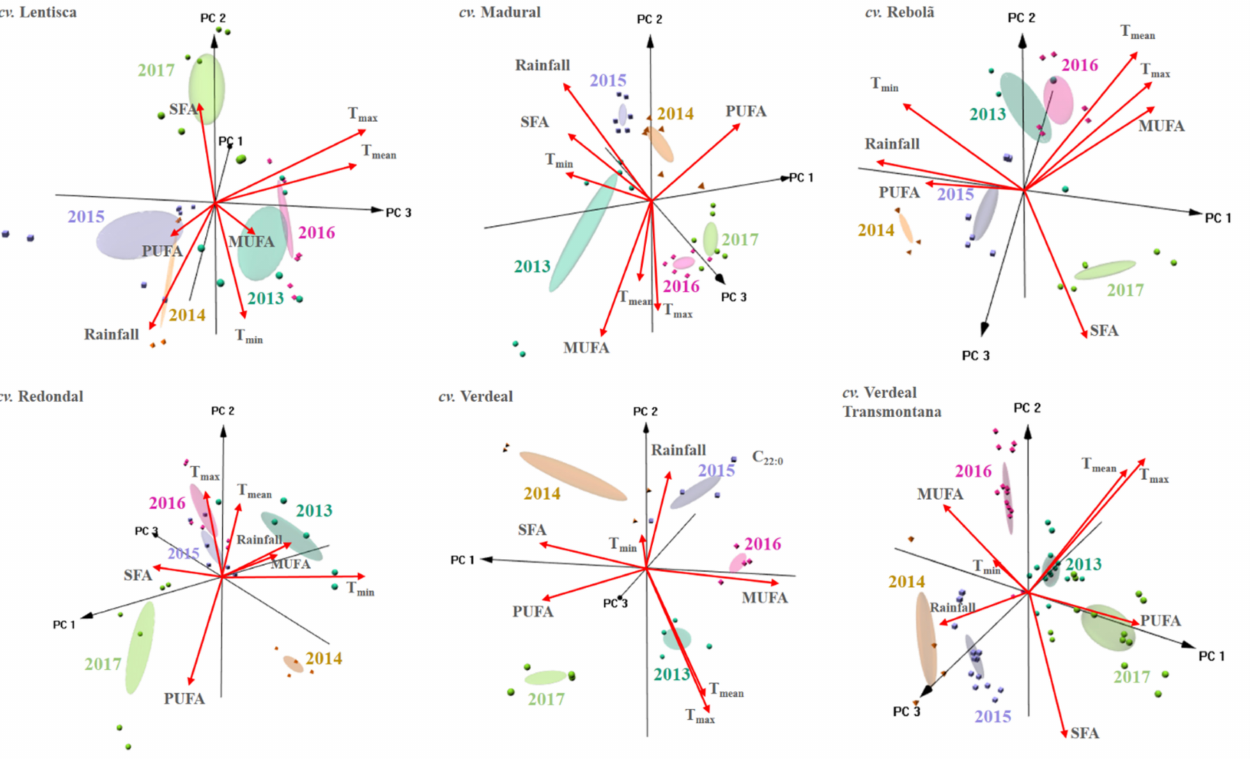
Figure 3. Principal component analysis for olive oils from each individual olive cultivar: 3D biplot showing the unsupervised pattern recognition according to crop year (2013 to 2017) on the basis of climatic data (minimum, mean, and maximum average temperatures (T min , T mean , and T max , respectively, in ◦ C) and total rainfall (mm) recorded in the months of August, September, and October in Mirandela region, northern Portugal) and fatty acid profile (%) (C 14:0 , C 16:0 , C 16:1 , C 17:0 , C 17:1 , C 18:0 , C 18:1 , C 18:2 , C 18:3 , C 20:0 , C 20:1 , C 22:0 , C 22:1 , C 24:0 ), MUFA, PUFA, and SFA proportions found in olive oils obtained from olives collected from centenarian trees of different cultivars (cvs. Lentisca, Madural, Rebol ã , Redondal, Verdeal, and Verdeal